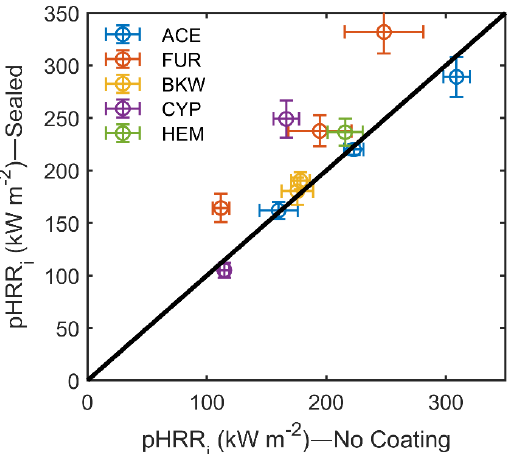
Figure 7. Comparison of the initial peak heat release rate (pHRR i ) between the uncoated and sealed specimens. The error bars represent the standard deviation.